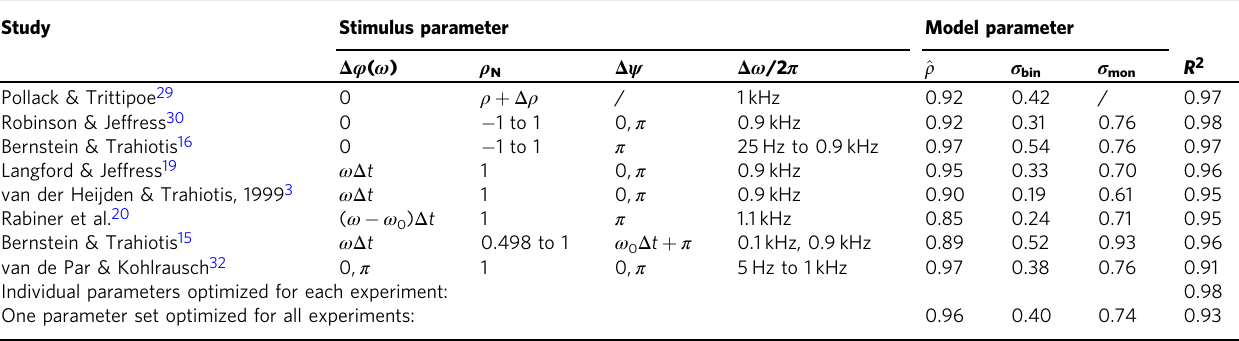
Table 1 Aggregation of stimulus and model